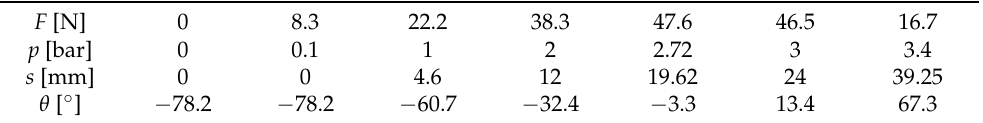
Table 2. Force F developed by the pneumatic muscle versus the stroke s (axial contraction) and the flexion/extension angle of the wrist θ